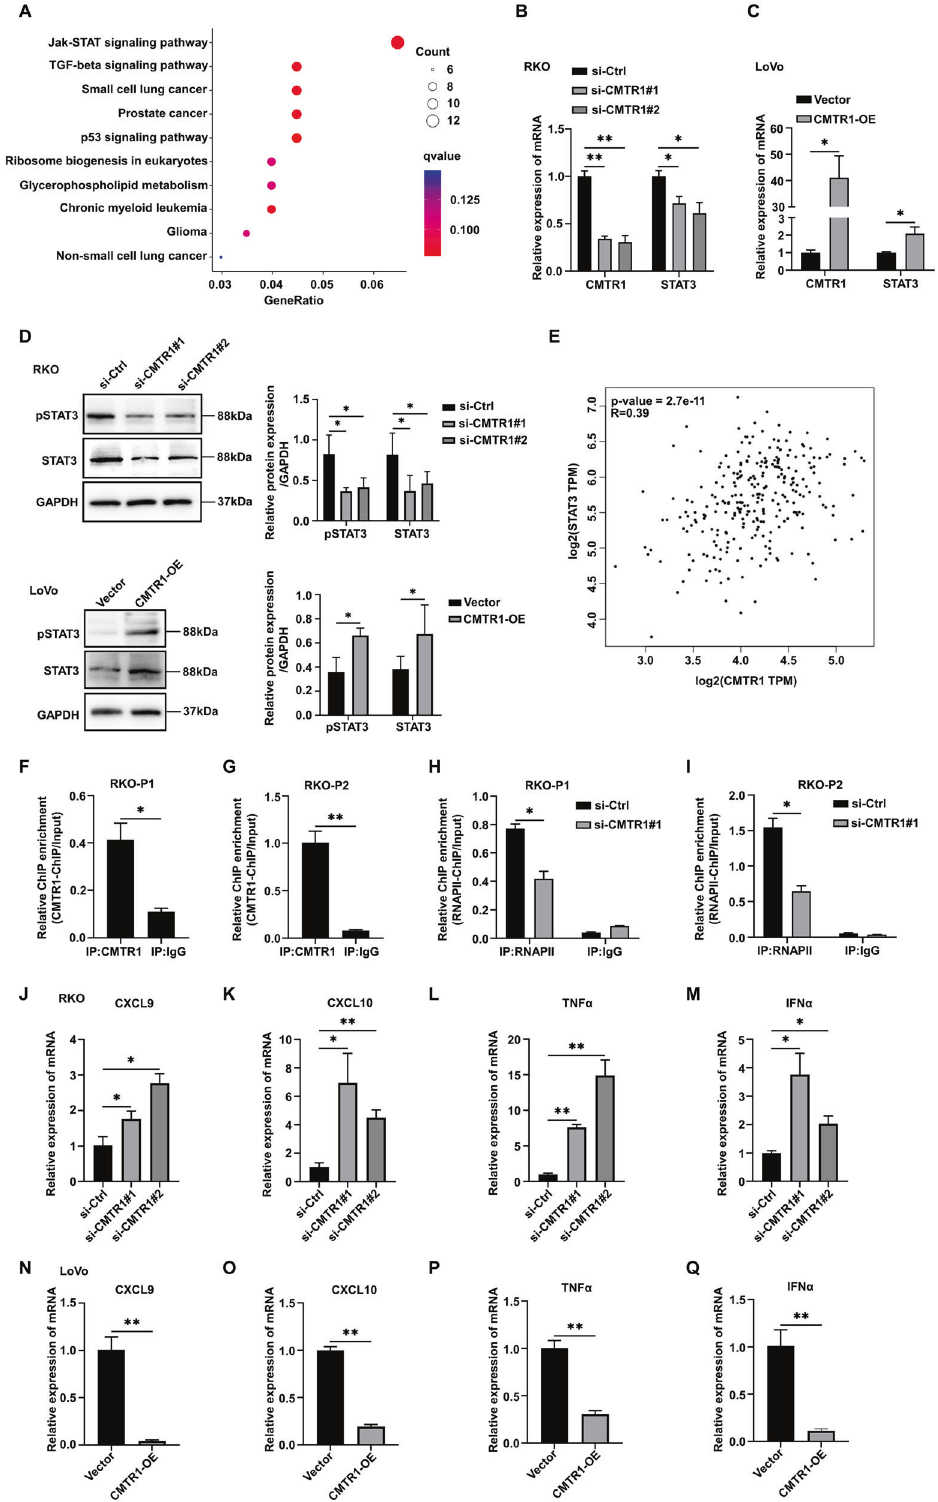
CMTR1 on representative cell cycle-related genes identi fi ed by RNA sequencing, such as CDKN1A, CDK6, and CCND1, are shown in Figure 2E – G. The results demonstrated that the knockdown of CMTR1 downregulated the expression of cell cycle-related genes, and this effect was further con fi rmed by RT ‒ qPCR and western